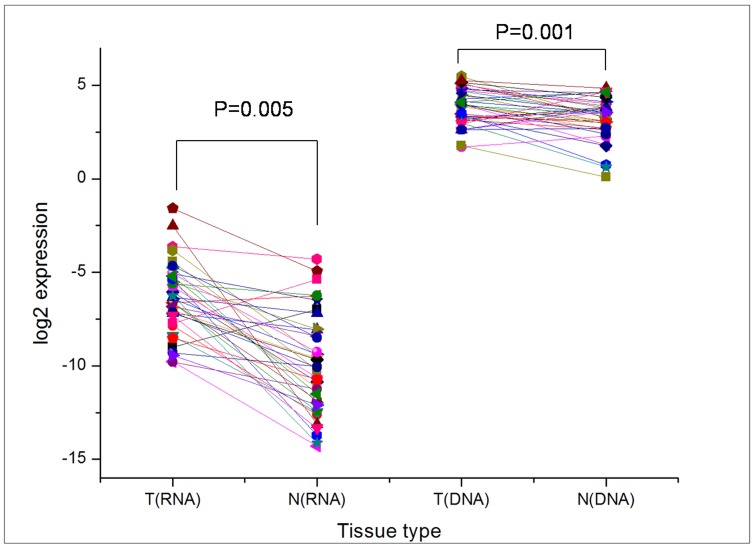
Quantitative RT-PCR analysis of the relative levels of BCOX1 mRNA transcripts.The relative levels of BCOX1 mRNA transcripts in 40 paired of breast cancer and surrounding non-tumor tissues were characterized by qRT-PCR suing specific primers. Briefly, total RNA was extracted from individual fresh frozen breast carcinomas and corresponding non-tumor breast tissues and reversely transcribed into cDNA, followed by qRT-PCR. The PCR amplification was performed in triplicate and the levels of BCOX1 mRNA transcripts were normalized against the control GAPDH. Data shown are individual values of the relative levels of BCOX1 mRNA transcripts for individual samples. T: Tumor tissues; N: the corresponding non-tumor tissues.